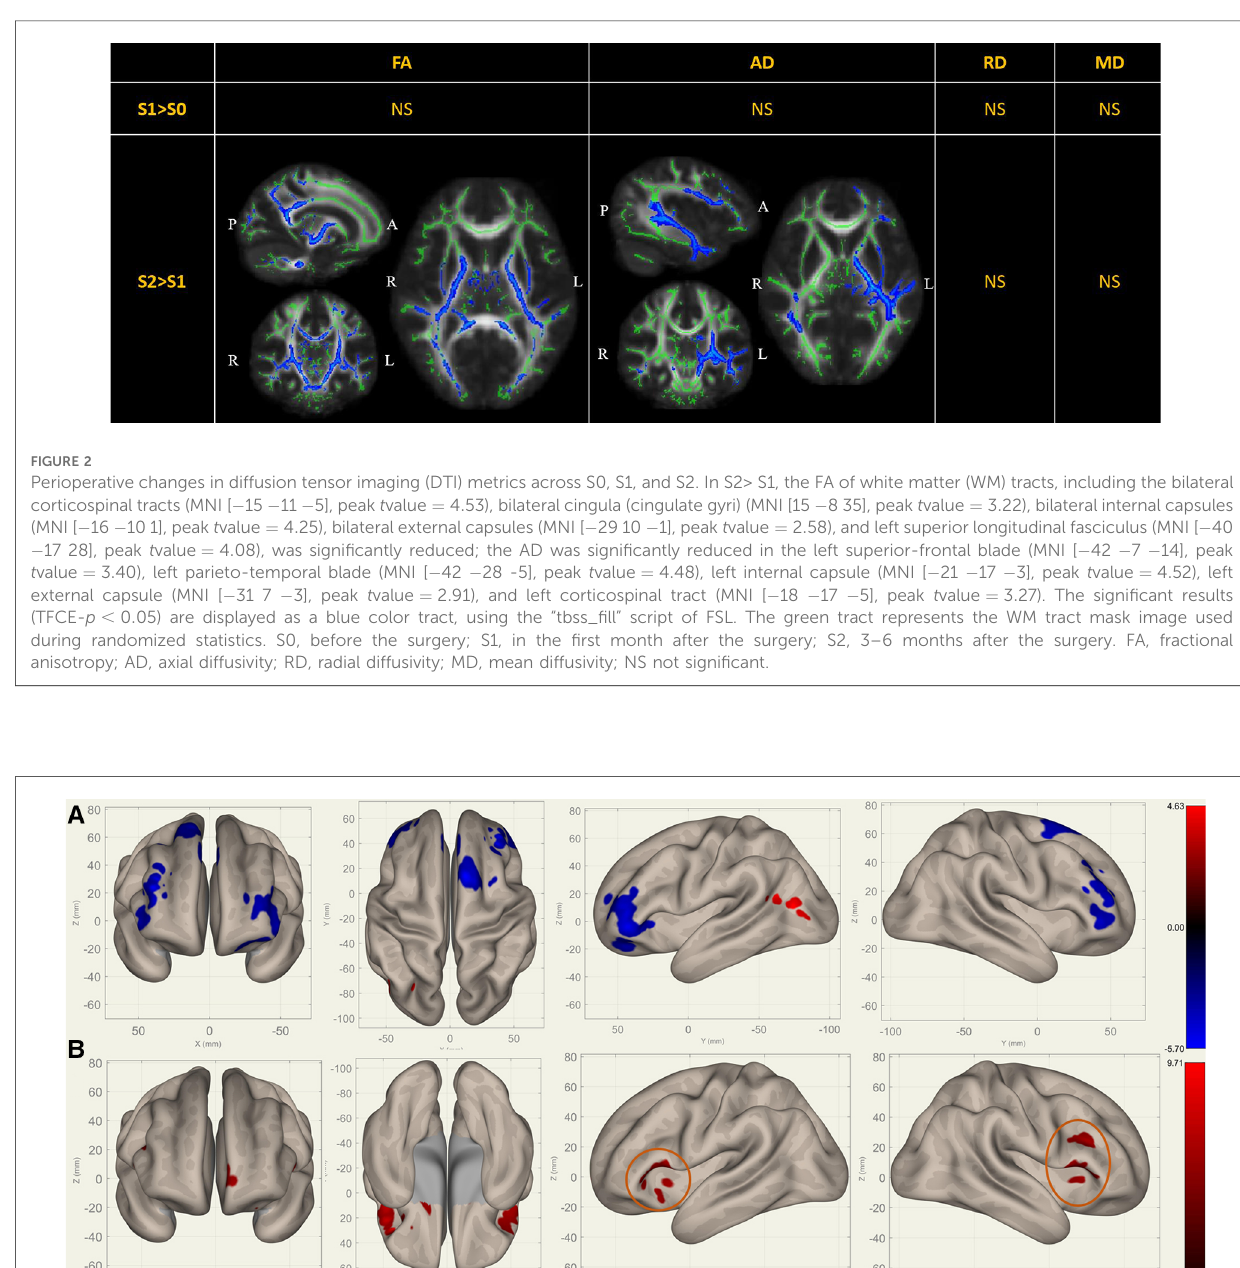
The analysis of the FC z -transformed score between 18 ROIs of the basal ganglia-frontal lobes ( Table 3 ) and 12 ROIs of the basal ganglia-motosensory cortex ( Table 4 ) revealed that the RT was primarily correlated with the FC in the caudates, including the caudate-bilateral insular cortices (IC)